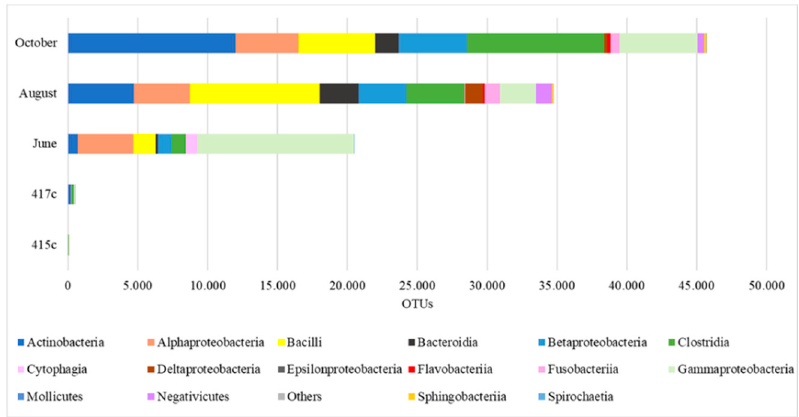
Figure 2. The actual abundance of bacterial aerosols in the urban air of Athens, at the Class level.